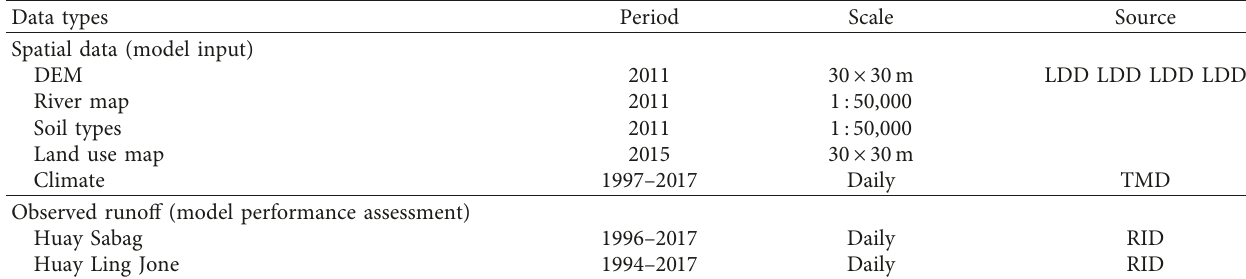
Table 1: Spatial input data for SWAT model.